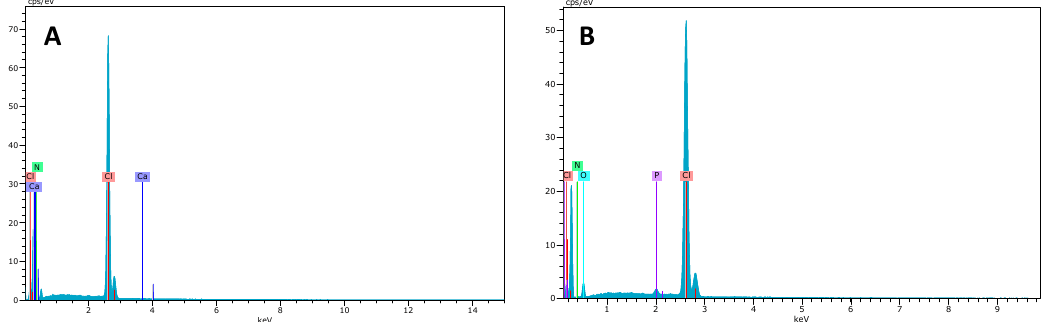
Figure 6. EDX analysis of membranes containing 30% w / w of IL after being used as separators for each feeding solution: CaCl 2 ( A ) and Na 2 HPO 4 ( B ).